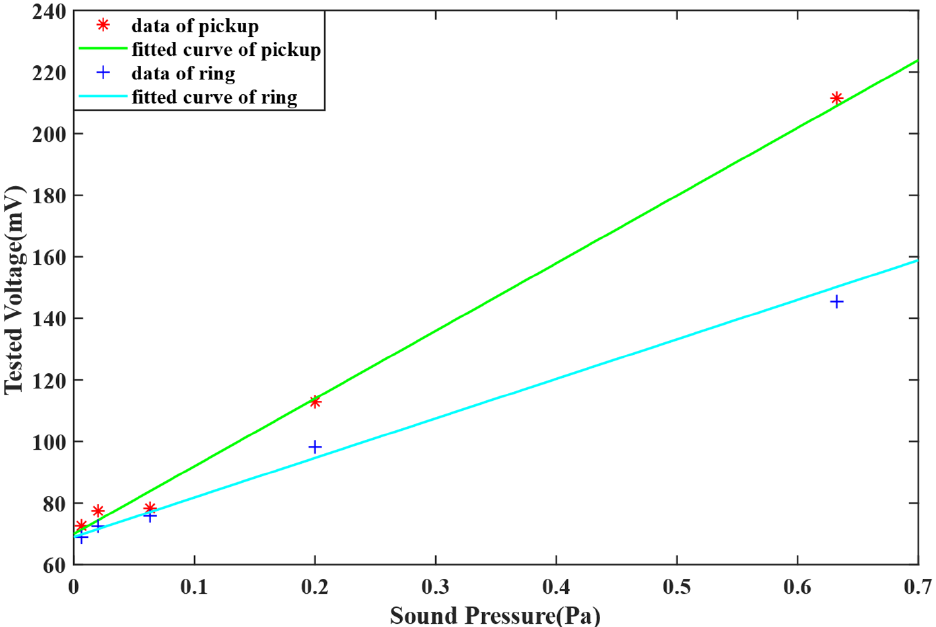
Figure 7. The experimental results of 500 Hz.